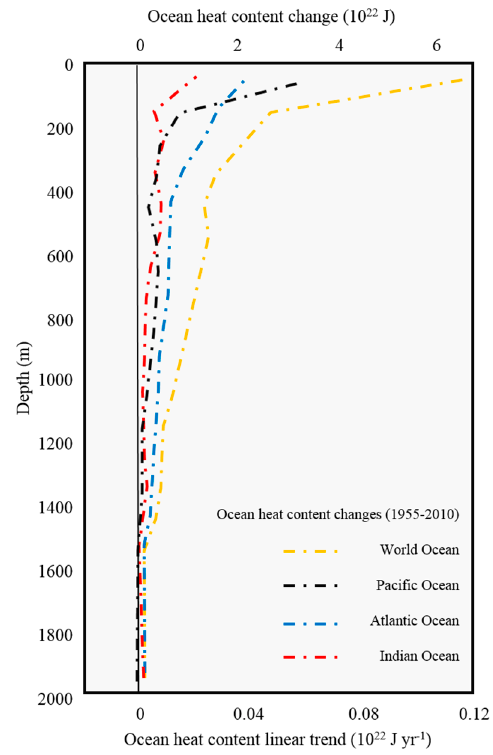
Figure 3. Linear trends and total increases of ocean basin heat content based on the linear trends of the global and individual basins as a function of depth (0–2000 m) at 100 m increments [29]. Reprinted from [29] with permission from Wiley (Copyright © 1999–2017 John Wiley & Sons, Inc).